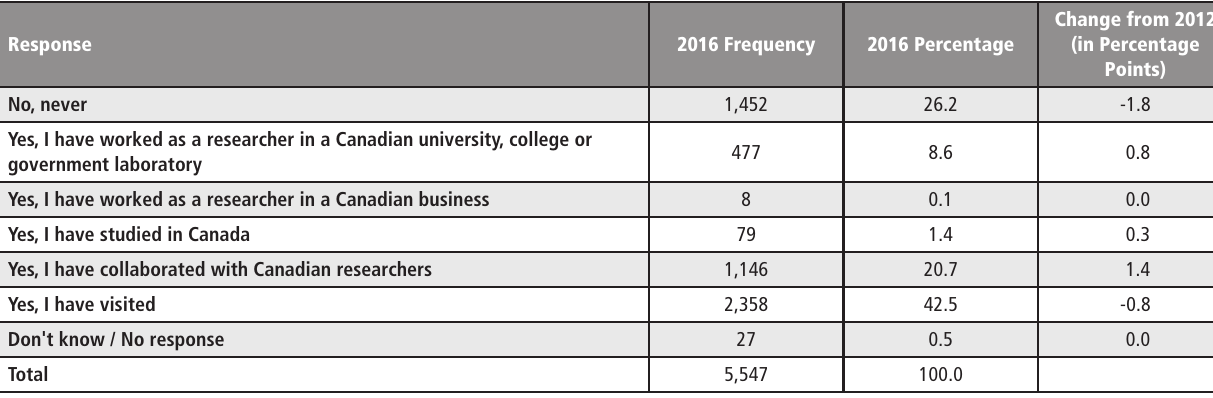
Survey Respondents’ Association with